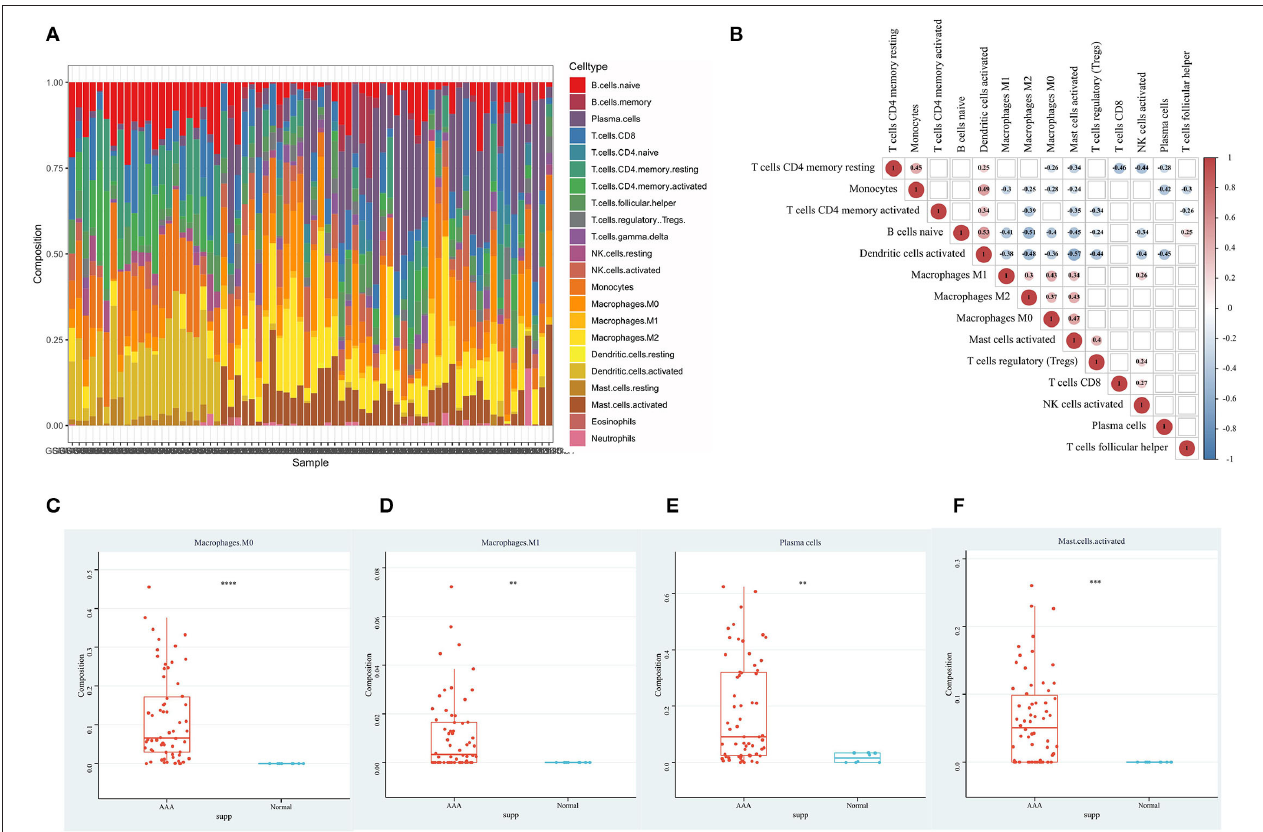
FIGURE 3 | The immune infiltration landscape of AAA. (A) The composition of 22 types of immune cells in each sample; (B) The correlation among immune cells in AAA samples, with red representing positive correlation and blue representing negative correlation. Correlation results that were not statistically significant were shown as blank; (C) The content of M0 macrophages in normal aortic samples and AAA samples; (D) The content of M1 macrophages in normal aortic samples and AAA samples; (E) The content of plasma cells in normal aortic samples and AAA samples; (F) The content of activated mast cells in normal aortic samples and AAA